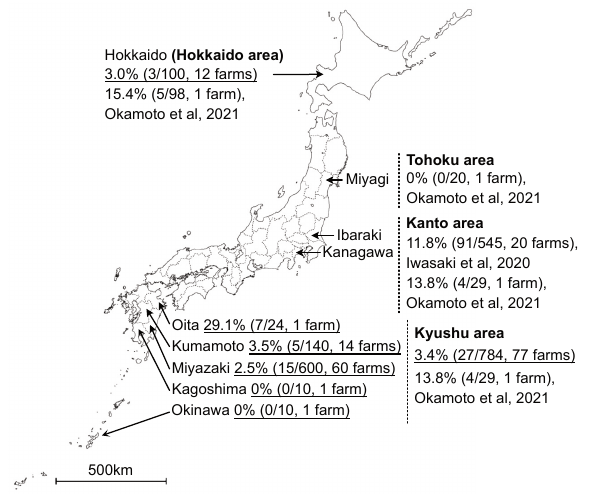
Figure 1. Map of Japan showing the positivity rate of bovine foamy virus (BFV) for each area. The map indicates the six prefectures (Hokkaido, Oita, Kumamoto, Miyazaki, Kagoshima and Okinawa) where sampling was performed in this study, and three prefectures (Miyagi, Ibaraki and Kanagawa) where sampling was performed in previous studies [18,19]. The BFV positivity rate is indicated by %, and the parentheses show the numbers of positive and tested samples and the number of tested farms in each prefecture and area. The surveys conducted by this study are indicated with